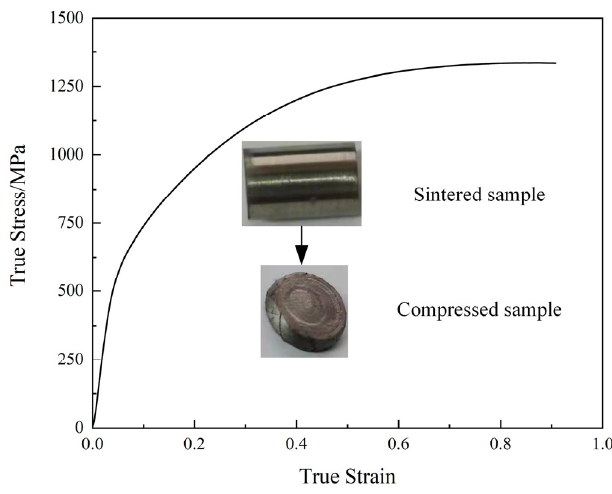
Figure 9. Mechanical properties of the sintered superalloy and the conventional superalloy via compressive